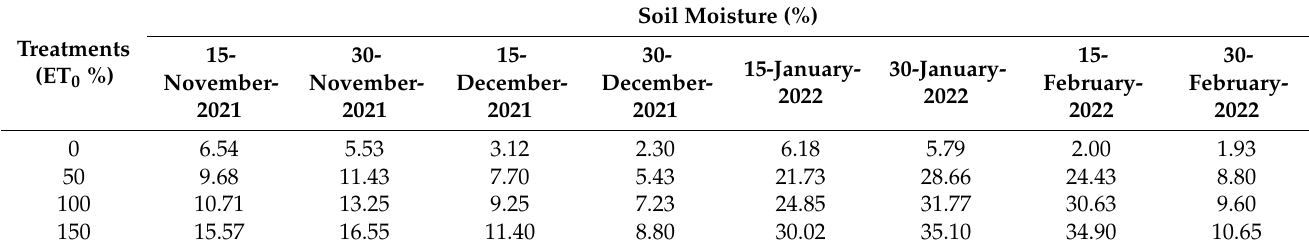
Table 2. Soil moisture monitoring with a frequency of 15